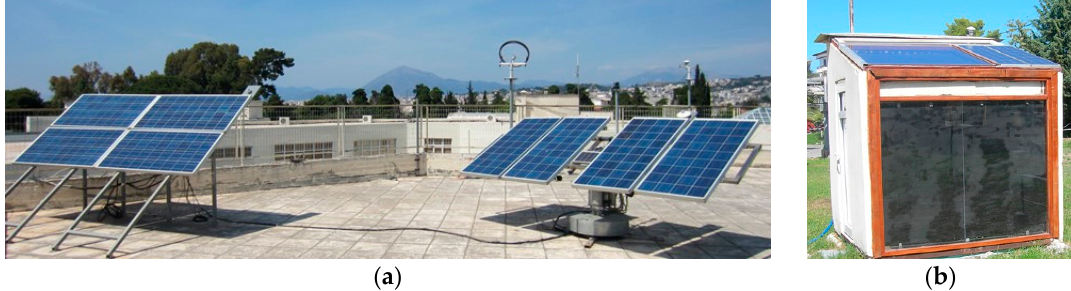
Figure 1. Experimental photovoltaic (PV) systems: ( a ) fixed-angle and two-axis sun-tracking PV; ( b ) building integrated photovoltaic (BIPV) test cell.